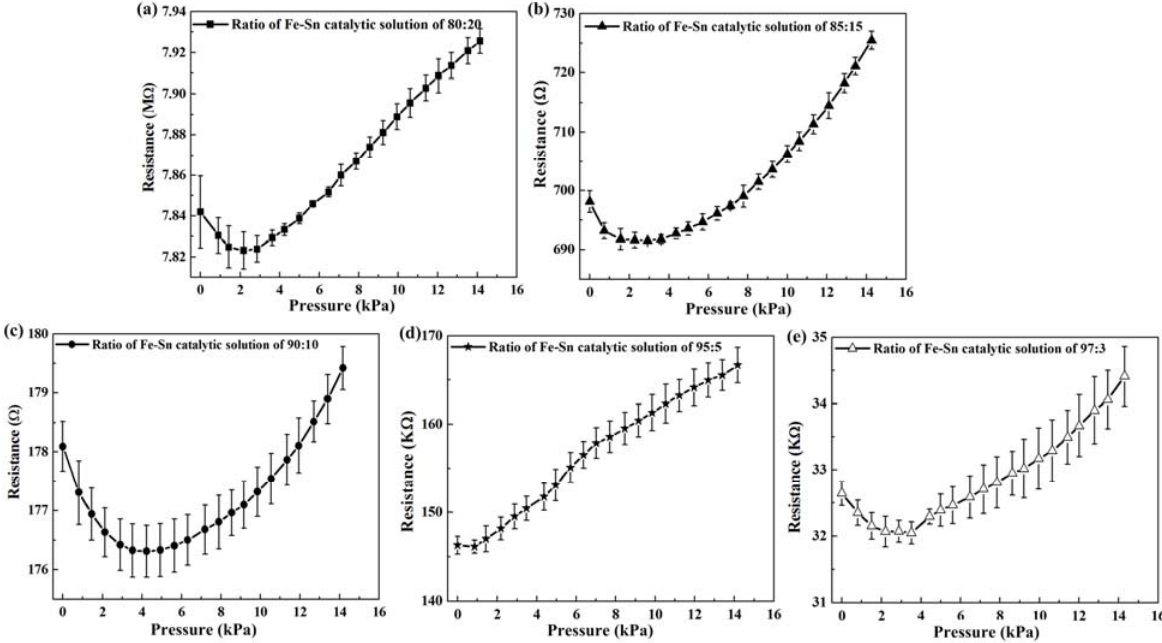
Figure 5. Relationship of resistivity vs . applied pressure for different mass ratios of Fe-Sn catalytic solution, ( a ) 80:20; ( b ) 85:15; ( c ) 90:10; ( d ) 95:5; and ( e )